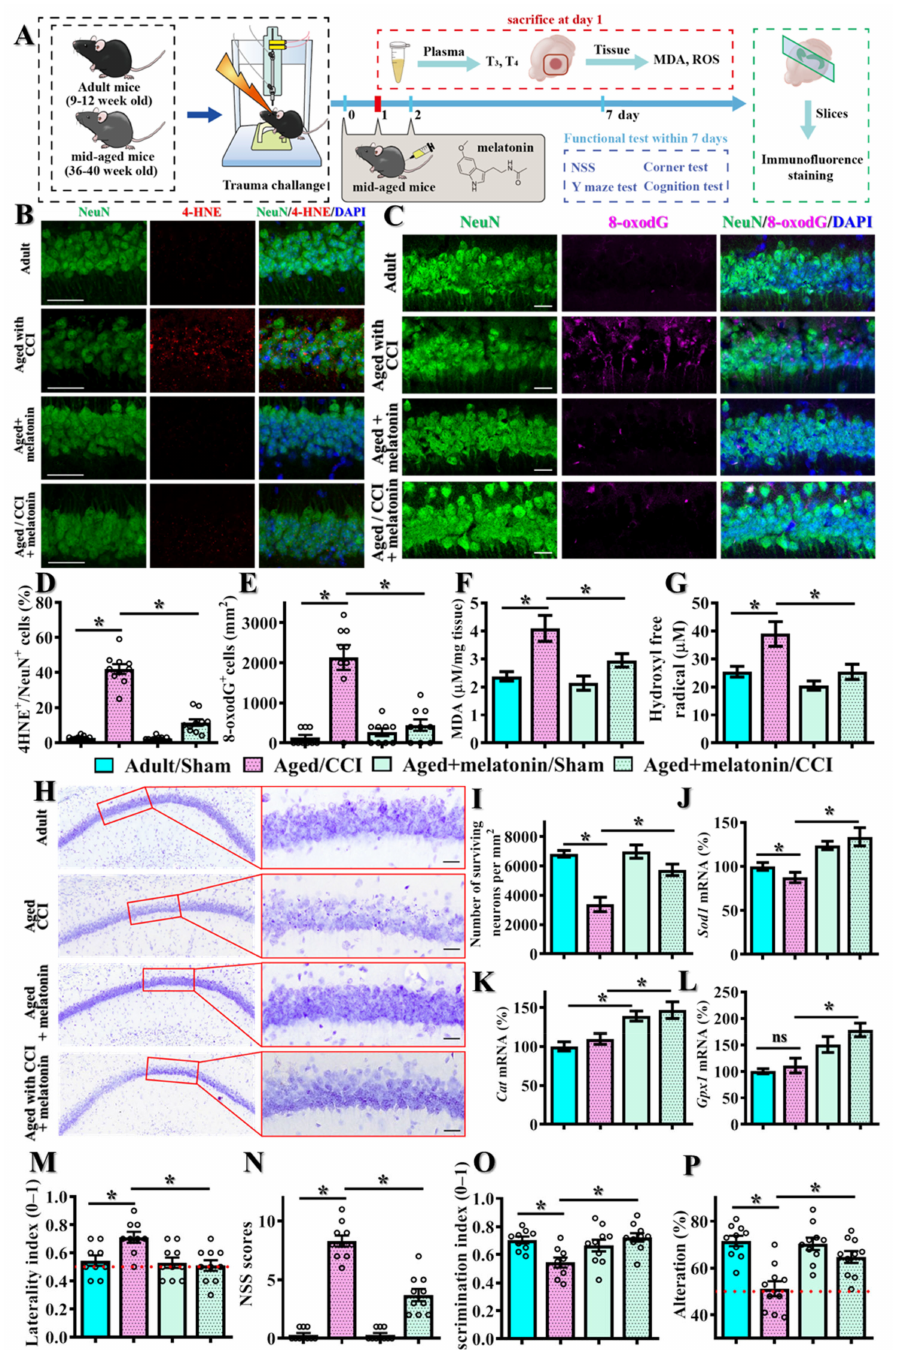
Figure 10. Amelioration of TBI-susceptible phenotypes by acute melatonin treatment. ( A ) Schematic illustration of the experimental designs with acute melatonin treatment; ( B ) Representative images of 4-HNE-positive (color in red) neurons (NeuN, color in green); ( C ) Representative images of 8-oxodG-positive (color in magenta) neurons (NeuN, color in green). Blue, DAPI signal for the nuclear stain. Scale = 25 µ m; ( D ) Quantification of the percentage of neurons with 4-HNE-positive puncta. (E) Quantification of the regional density of the 8-oxodG-positive neurons. n = 15 images from 5 mice in ( D , E ); ( F ) Quantification of the levels of malondialdehyde; ( G ) Quantification of the production of hydroxyl free radicals; ( H – I ) Representative images of the Nissl stains and quan- tification analyses showing the surviving neurons in the hippocampal CA1 region. n = 15 images from 5 mice; ( J – L ) Quantification of the relative expression levels of Sod1, Cat and Gpx1 mRNAs